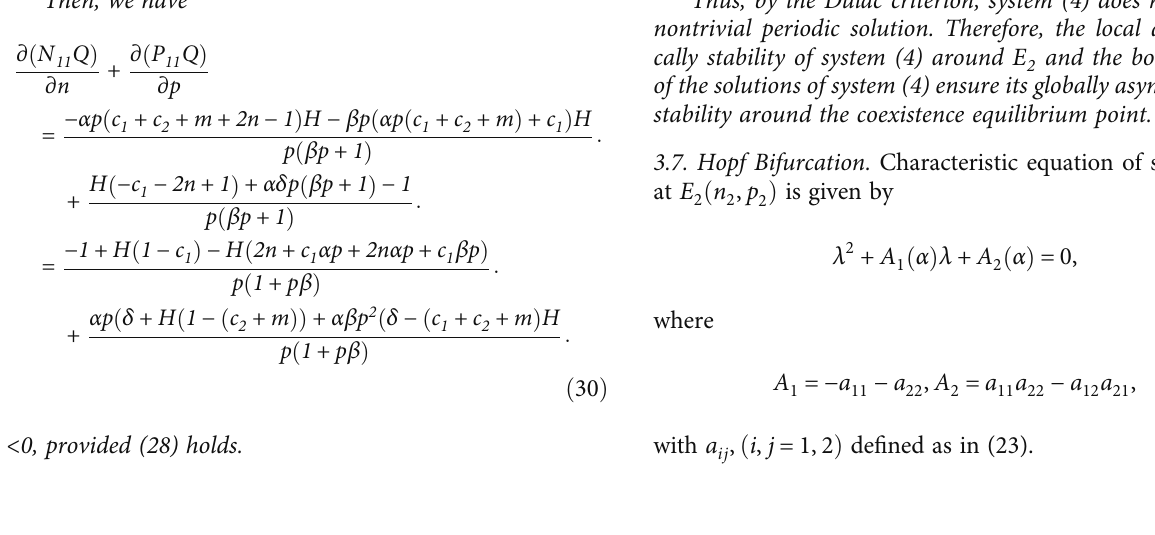
Figure 3: (a) The density of prey population for the parameter values as in Table 2 except c (b) The density of predator population for the parameter values as in Table 2 except c 2 = 0 : 05, α = 0 : 25, and β = 0 : 2 and c 1 = 0 : 02,0 : 1,0 : 3,0 : 5 .